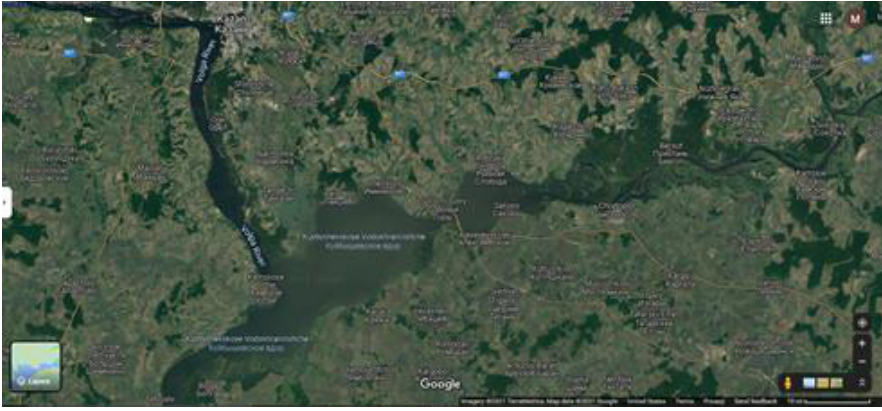
Figure 1. A bird view of the farm’s location